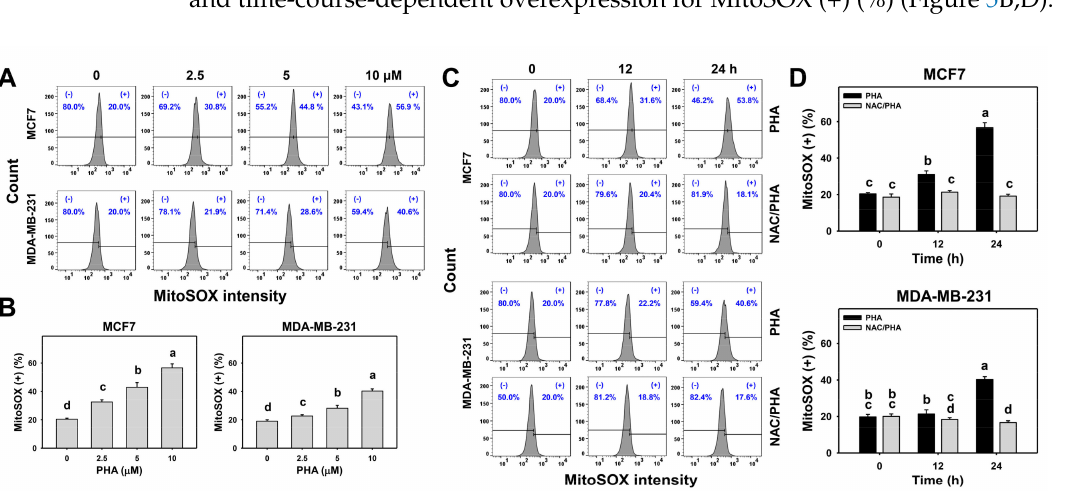
Figure 5. PHA triggered MitoSOX generation in two breast cancer cell lines. ( A , B ) MitoSOX patterns and statistical analysis for concentration responses to PHA. Cells were incubated with PHA (0 (0.05% DMSO as control), 2.5, 5, and 10 µ M) for 24 h. (+) indicates MitoSOX (+) (%). ( C , D ) Pattern and statistical analysis for NAC pretreatment responses in MitoSOX intensity changes in PHA-post-treated breast cancer cells. Following pretreatment with NAC, cells were processed with post-treatment for 0 (control with 0.05% DMSO) and 10 µ M PHA for 0, 12, and 24 h, i.e., PHA and NAC/PHA. Data, means ± SDs ( n = 3 independent experiments). Experiments without the same top-labeled letters indicate significant changes according to multiple ANOVA comparisons ( p < 0.05 to